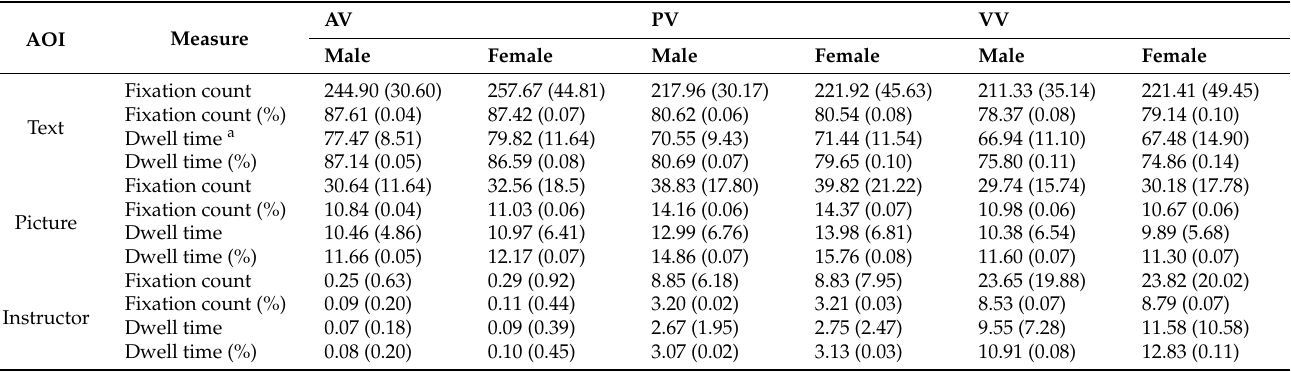
Table 3. Visual attention distribution statistics for the videos in the AV, PV, and VV